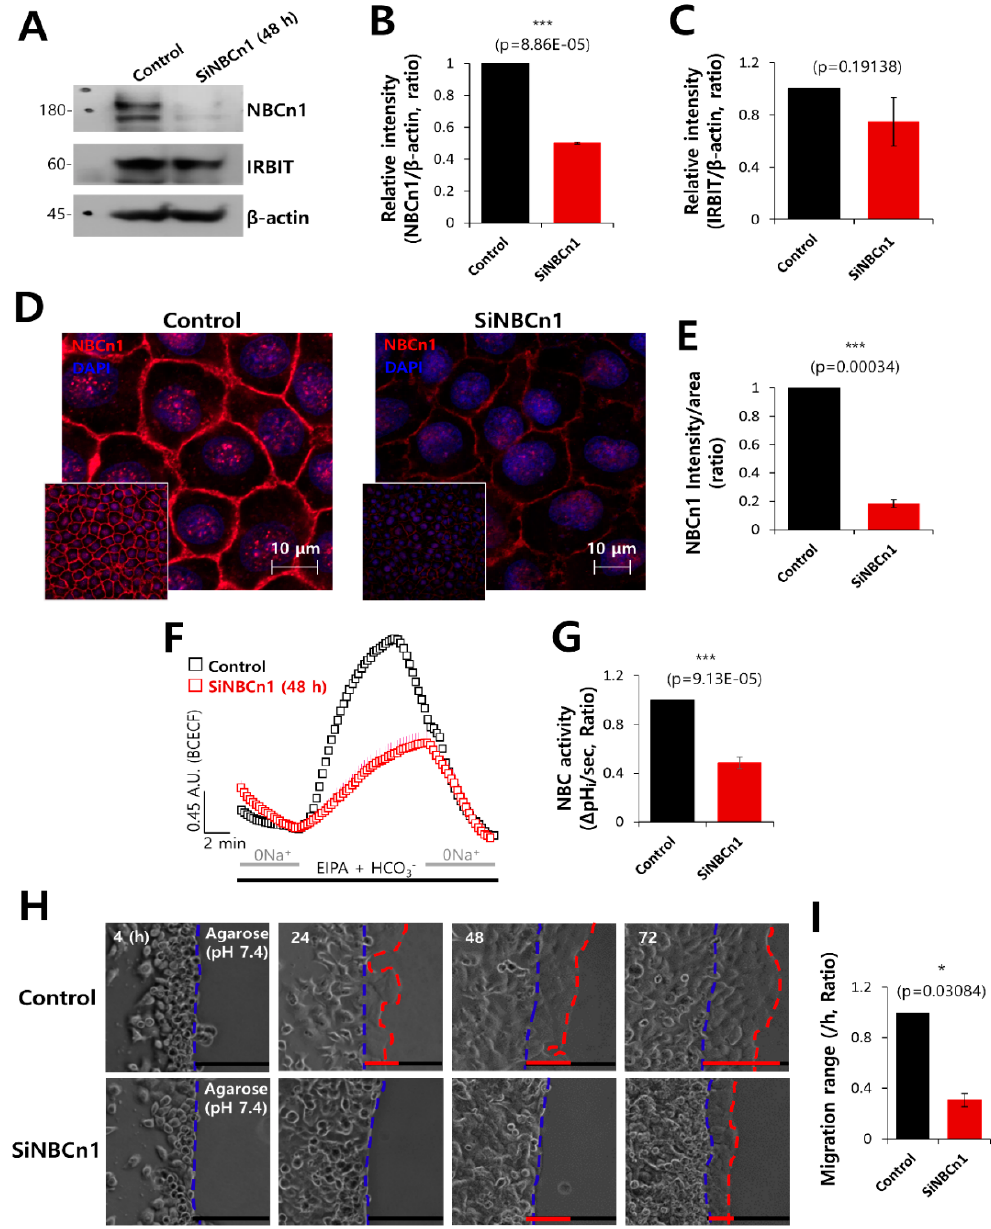
Figure 5. NBCn1 knockdown reduced cell motility. ( A ) Protein expression of IRBIT and NBCn1 in A549 cells in the presence of SiRNA-NBCn1 (SiNBCn1). IRBIT and β -actin were used as loading controls. ( B , C ) Analysis of the relative intensity of NBCn1 and IRBIT. The bars indicate the mean ± SEM of the intensities of NBCn1 and IRBIT normalized by β -Actin ( n = 3). ( D ) Immunostaining images of NBCn1 (red) and nucleus (DAPI, blue), with or without SiNBCn1. The smaller panels represent the original magnified images. The scale bars in the magnified images represent 10 µ m. ( E ) The bars indicate the mean ± SEM of the intensity of NBCn1 per area ( n = 3). ( F ) NBC activity in A549 cells with (red open square) or without (control, black open square) SiNBCn1 at 48 h. Averaged traces are presented. ( G ) The bars indicate the mean ± SEM of NBC activity ( n = 4). ( H ) Time-dependent representative images of migration of A549 cells toward the agarose spots containing PBS (pH 7.4) and in the presence or absence of SiNBCn1 for indicated times. ( I ) Analysis of migration range per hour. The bars indicate the mean ± SEM of data ( n =